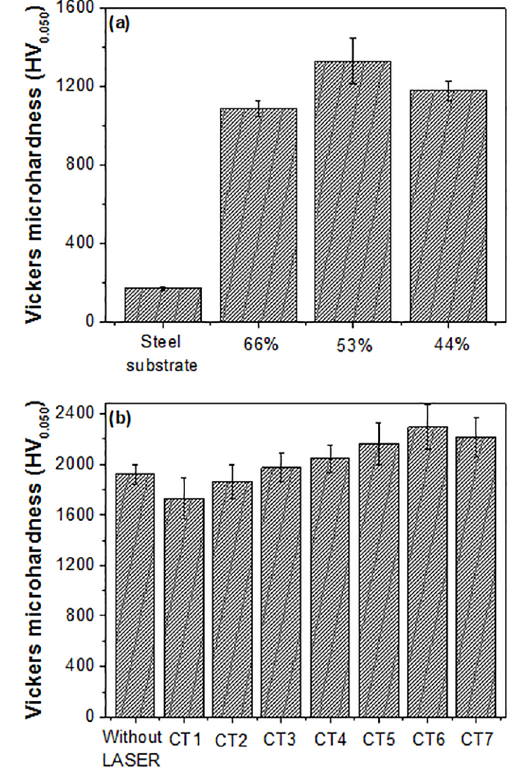
Cr Nb B (at%) 60 8 8 24